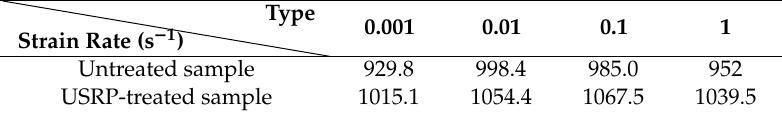
Table 2. The peak stress (MPa) of the true stress–strain